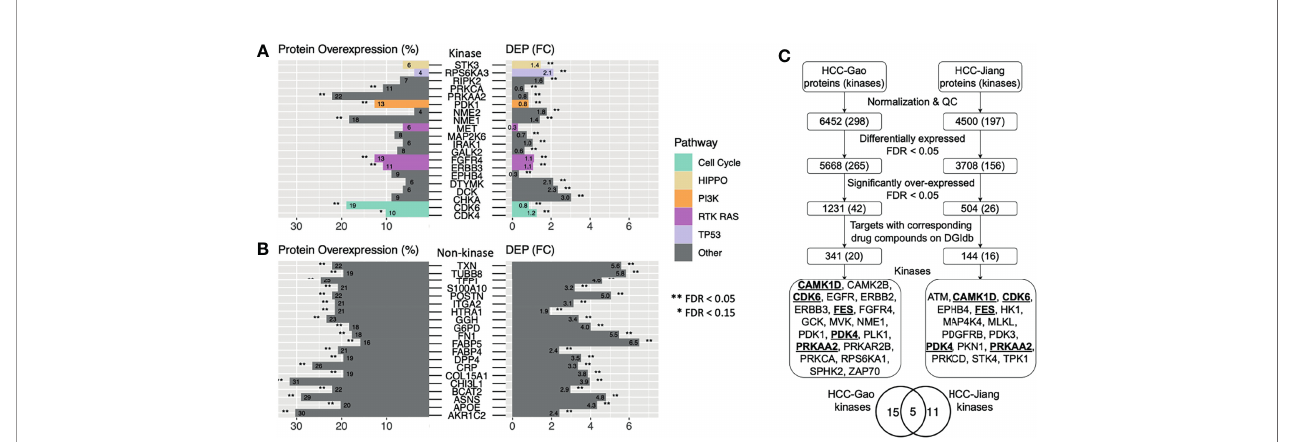
FIGURE 3 | Candidate HCC protein targets showing protein overexpression, differential expression in tumor vs. normal tissues, and drug compounds as indicated by DGIdb. (A) Druggable kinases with corresponding drug compounds based on DGIdb that showed signi fi cantly higher tumor vs. normal expression and protein overexpression in the HCC-Gao cohort. (B) Druggable non-kinase proteins with corresponding drug compounds based on DGIdb that showed signi fi cantly higher tumor vs. normal expression and protein overexpression in the HCC-Gao cohort. (C) Flowchart showing the steps in the pipeline that generated the candidate HCC protein targets from two HCC